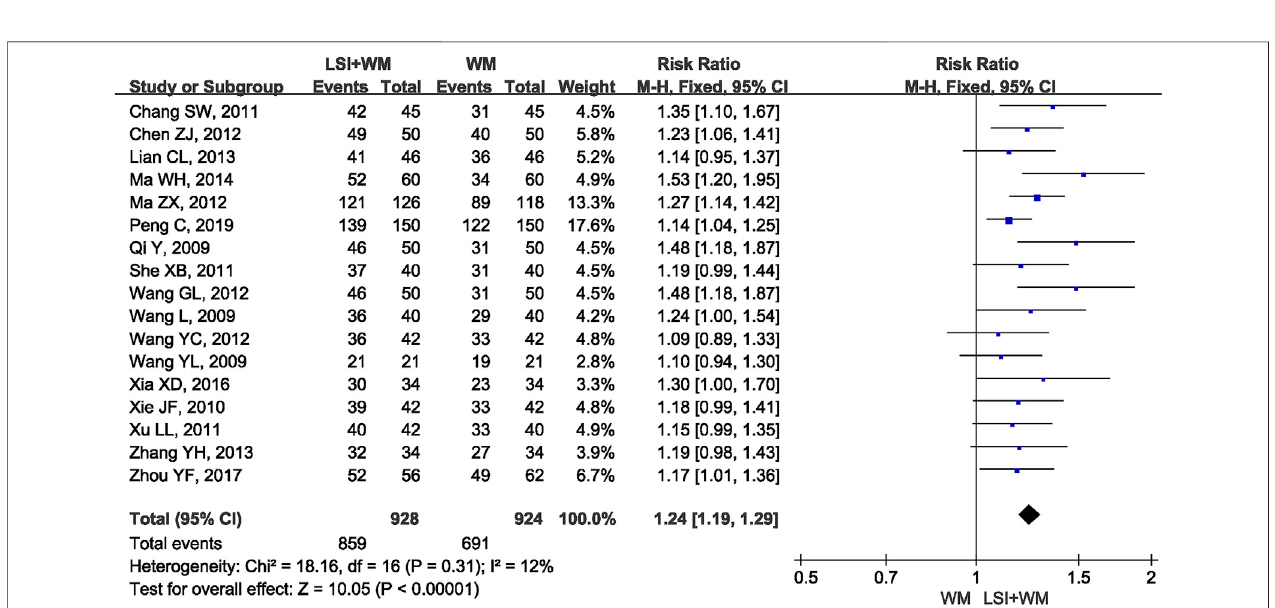
FIGURE 2 | Forest plot of clinical effective rate of ligustrazine injection in treating ACI. LSI is ligustrazine injection and WM is Western medicine.